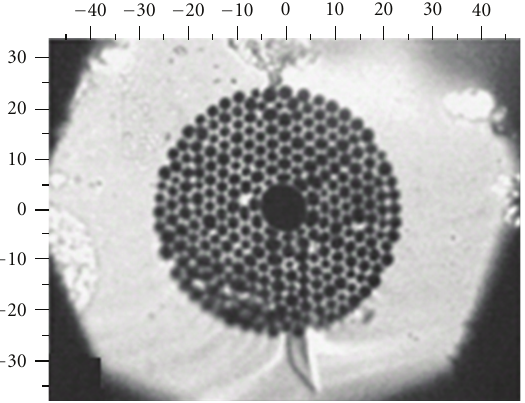
Figure 1: Micrograph of the cross-section of a single HCPCF (scale: µ m).